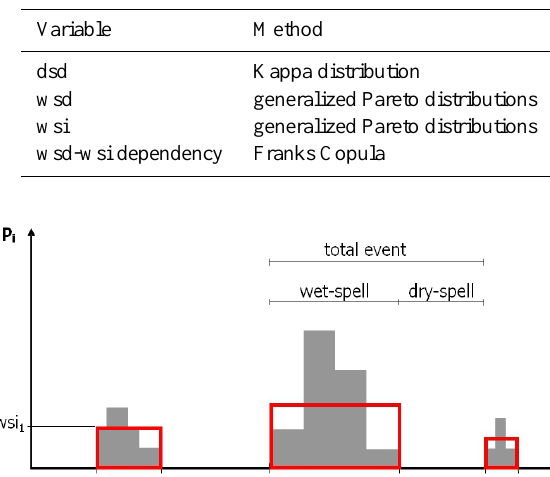
Table 1. Methods used in the ARM.